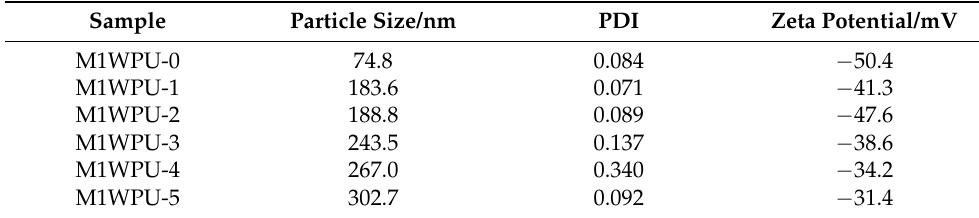
Table 2. Results of the particle size and the zeta potential for different HTPB contents. Sample